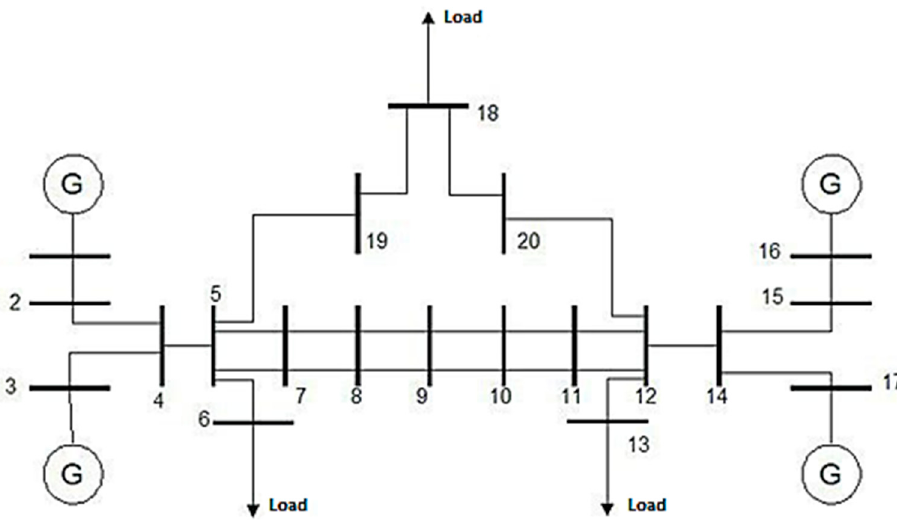
Figure 5. 20-bus bar power system .